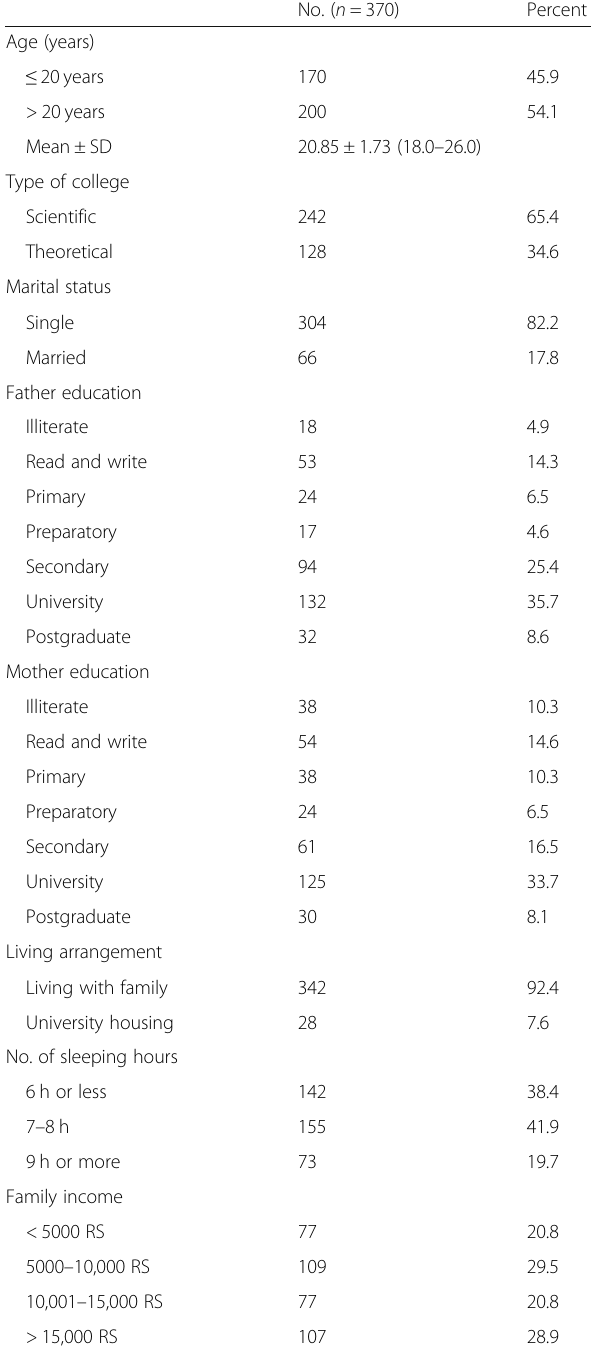
Table 1 Sociodemographic features of female students at